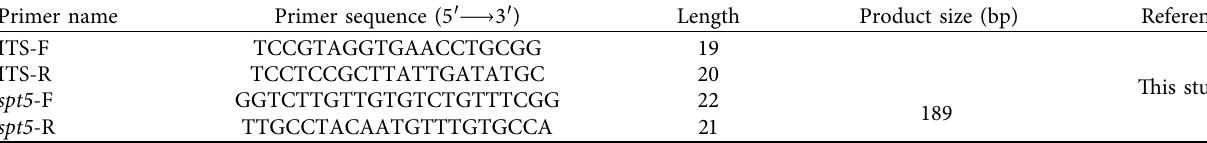
Table 1: Primers used in qualitative and quantitative PCR.